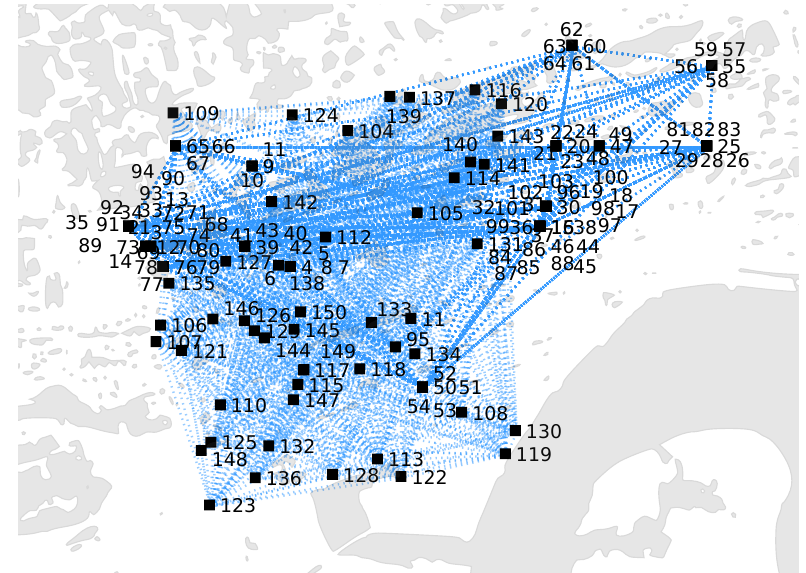
Figure 3. Snapshot of the considered dataset: black squares denote the IoT devices in the area, whereas the links indicate social interconnection between a couple of